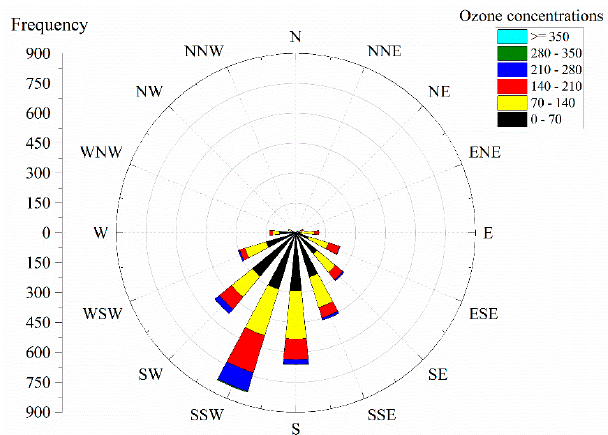
Figure 13. Correlation between O 3 concentration and wind direction in Taiyuan from April to August.